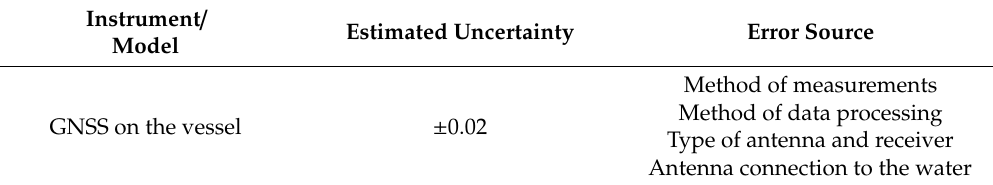
Figure 1. Design of validation and comparison scenarios. Table 1. Error budget of estimated uncertainties (m) of instruments and models